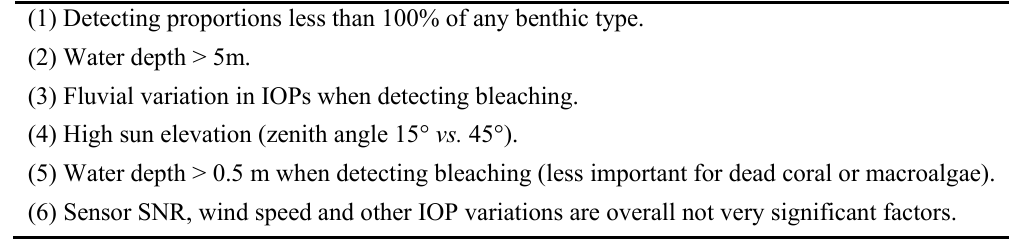
Table 6. Overall list of confounding factors for accuracy of benthic type separability ordered by significance (based on the structure of the experiment design presented